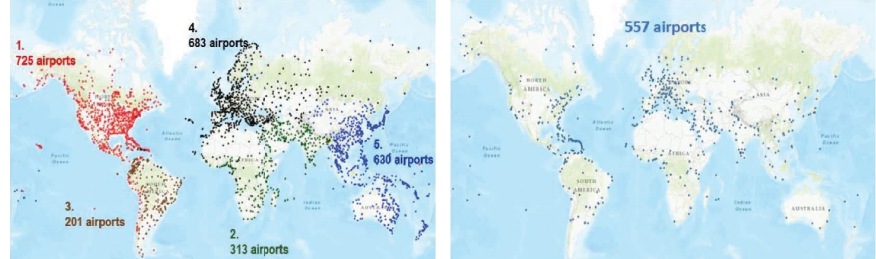
Figure 3: Te fgure at the left represents the airports in the uncovered large local components. Tey are in well-delimited geographic areas. Each color represents a component. (1) North America-Caribbean, (2) Europe-Russia, (3) East and Southeast Asia-Oceania, (4) Africa- Middle East-Southern Asia, and (5) South America. Te fgure at the right represents the airports of the largest global component. In contrast to local components, they are scattered all over the